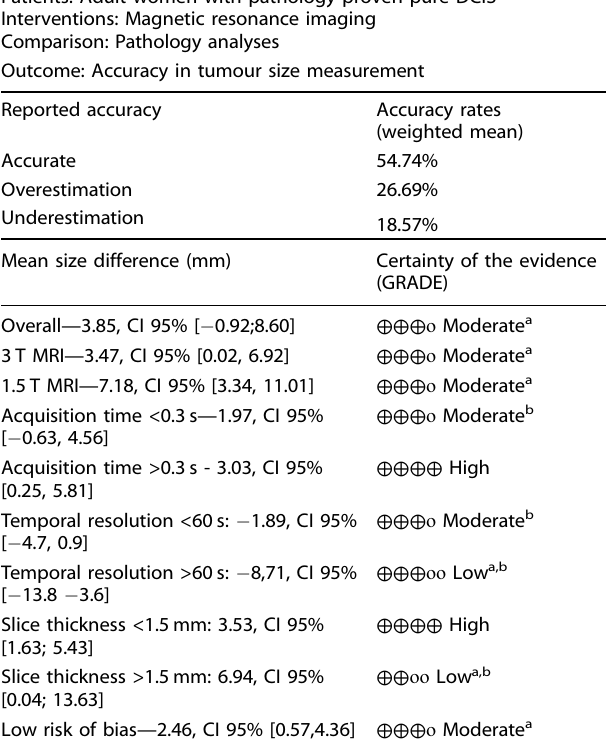
Table 3. Summary of fi ndings. Patients: Adult women with pathology proven pure DCIS Interventions: Magnetic resonance